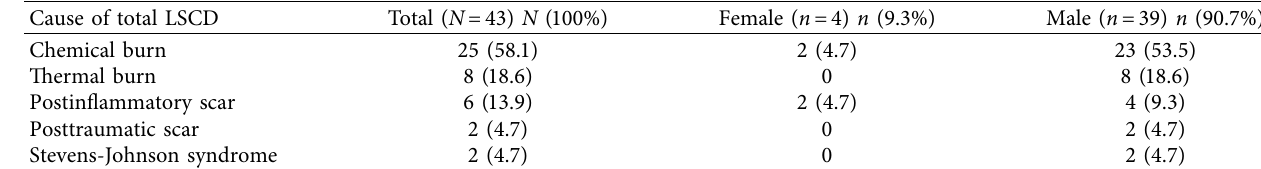
Table 1: Causes of total limbal stem cell deficiency (% in brackets).